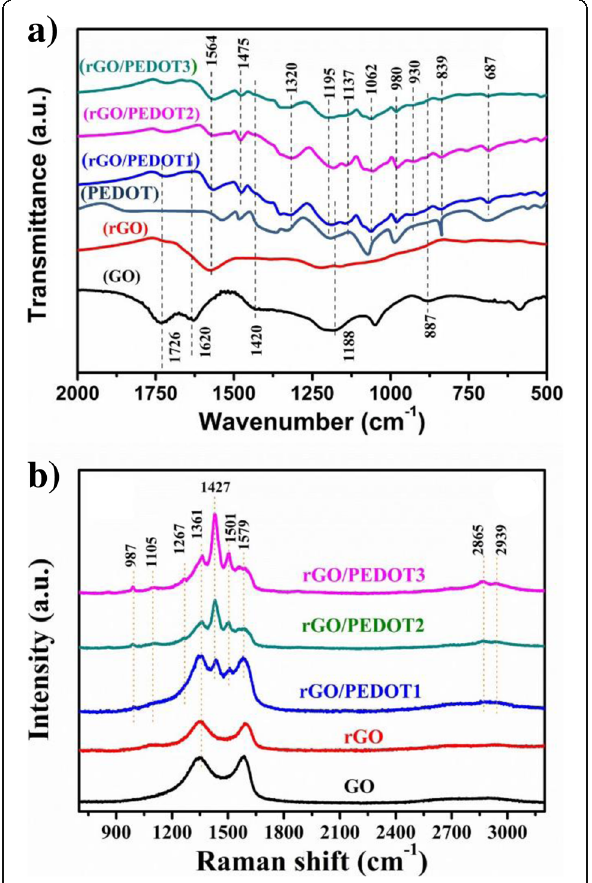
Fig. 3 a FT-IR spectra of GO, hydrothermal-treated rGO,